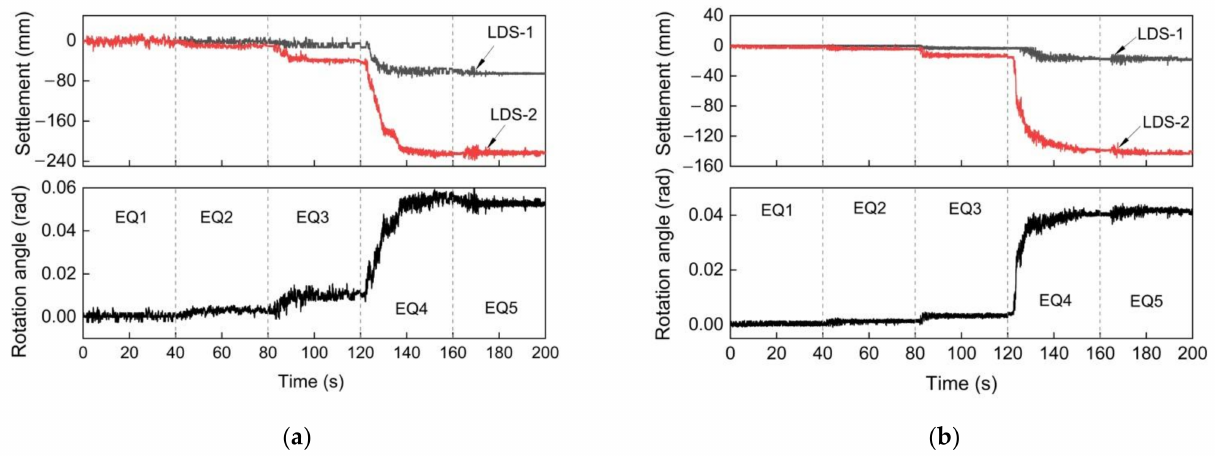
Figure 11. Crest settlements and crest rotation angle under seismic excitation: ( a ) 1# model; ( b ) 2#